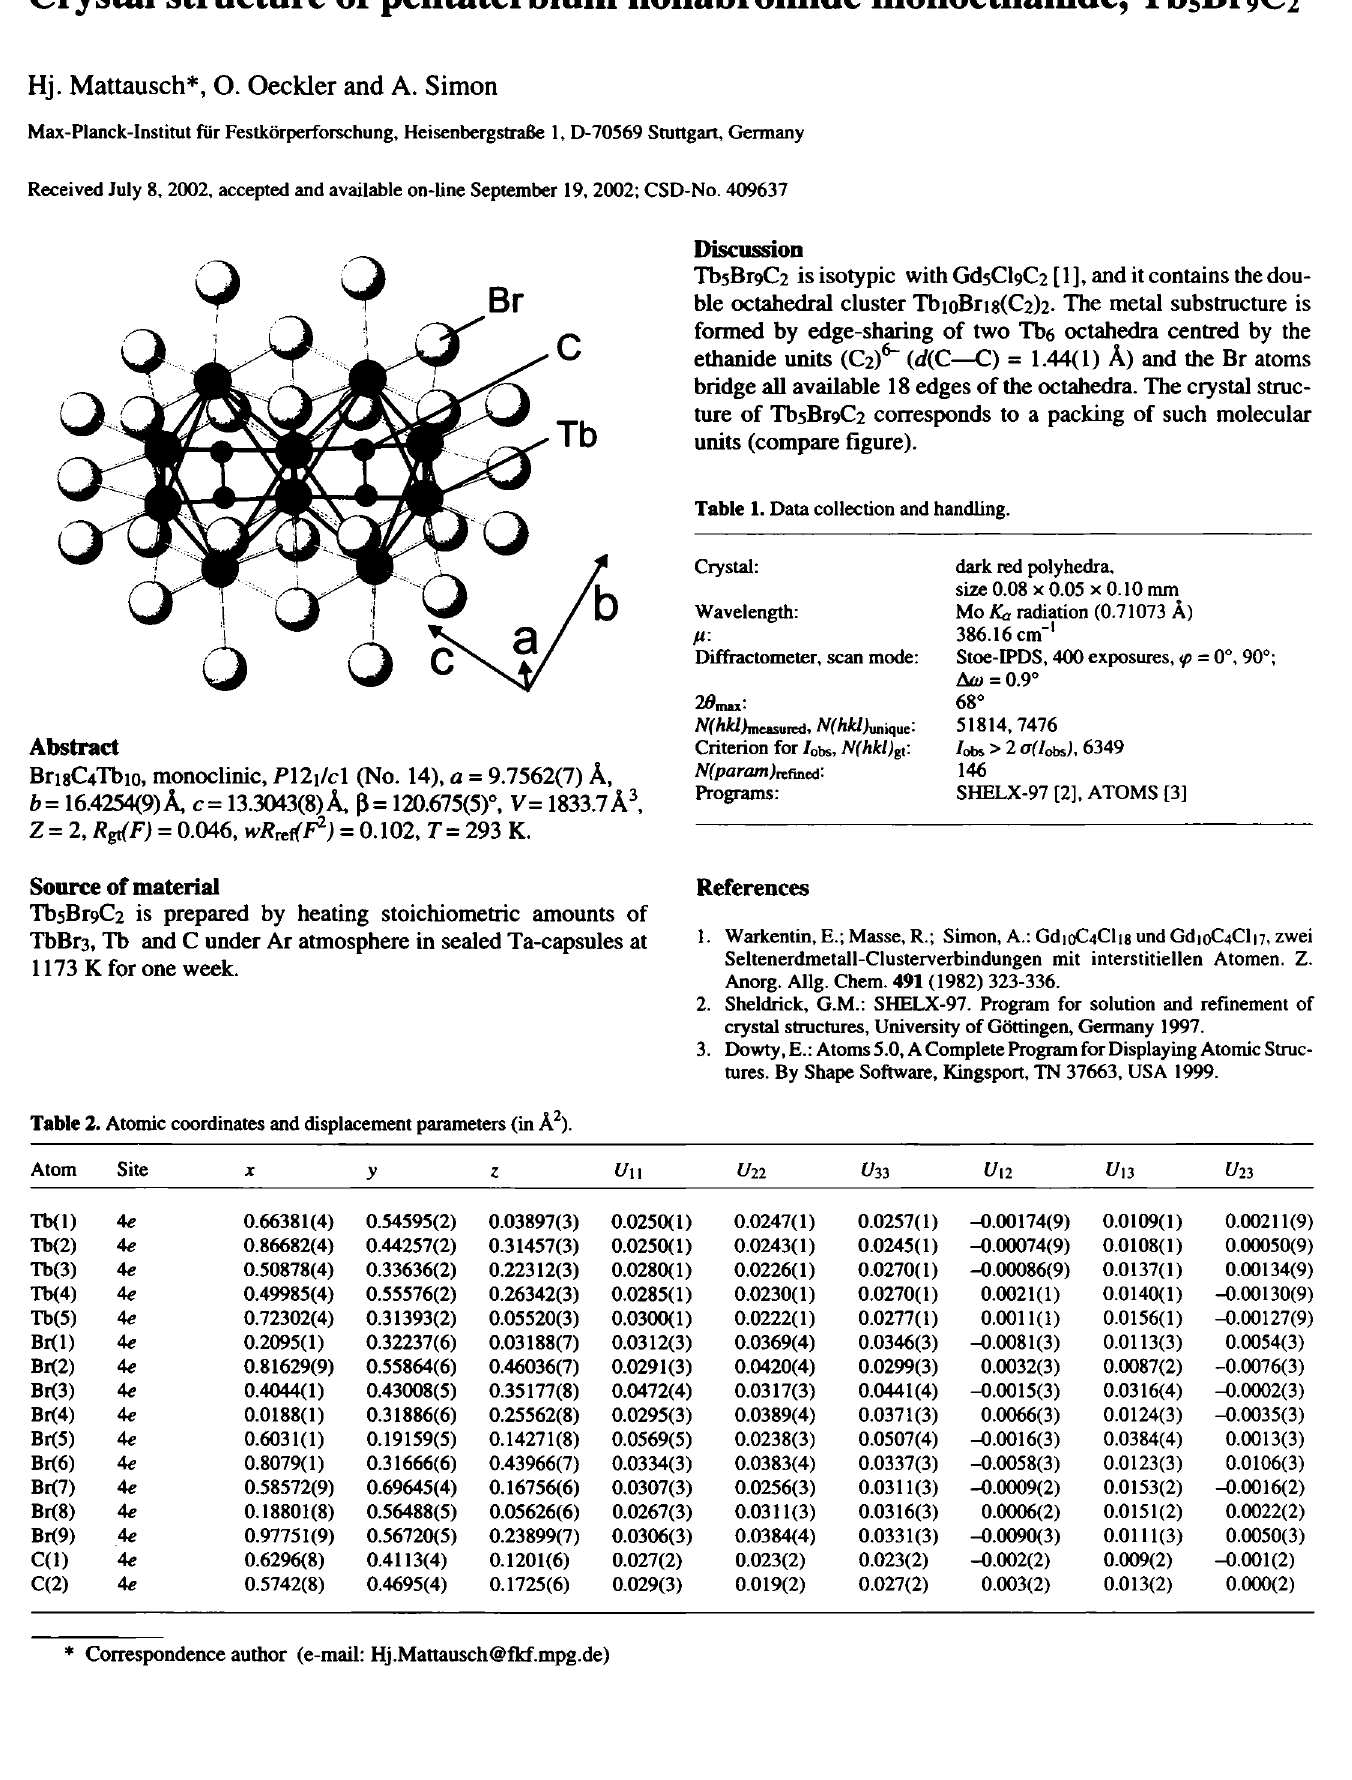
Table 1. Data collection and handling. Crystal: